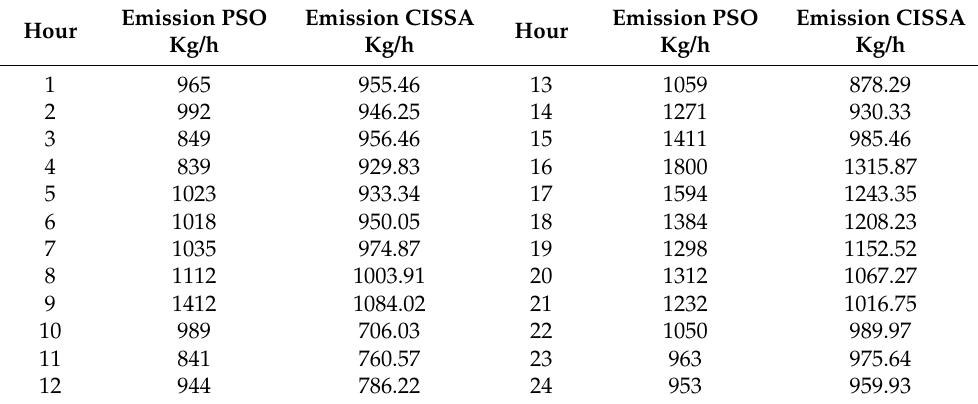
Table 19. Emissions comparison between CISSA and PSO.